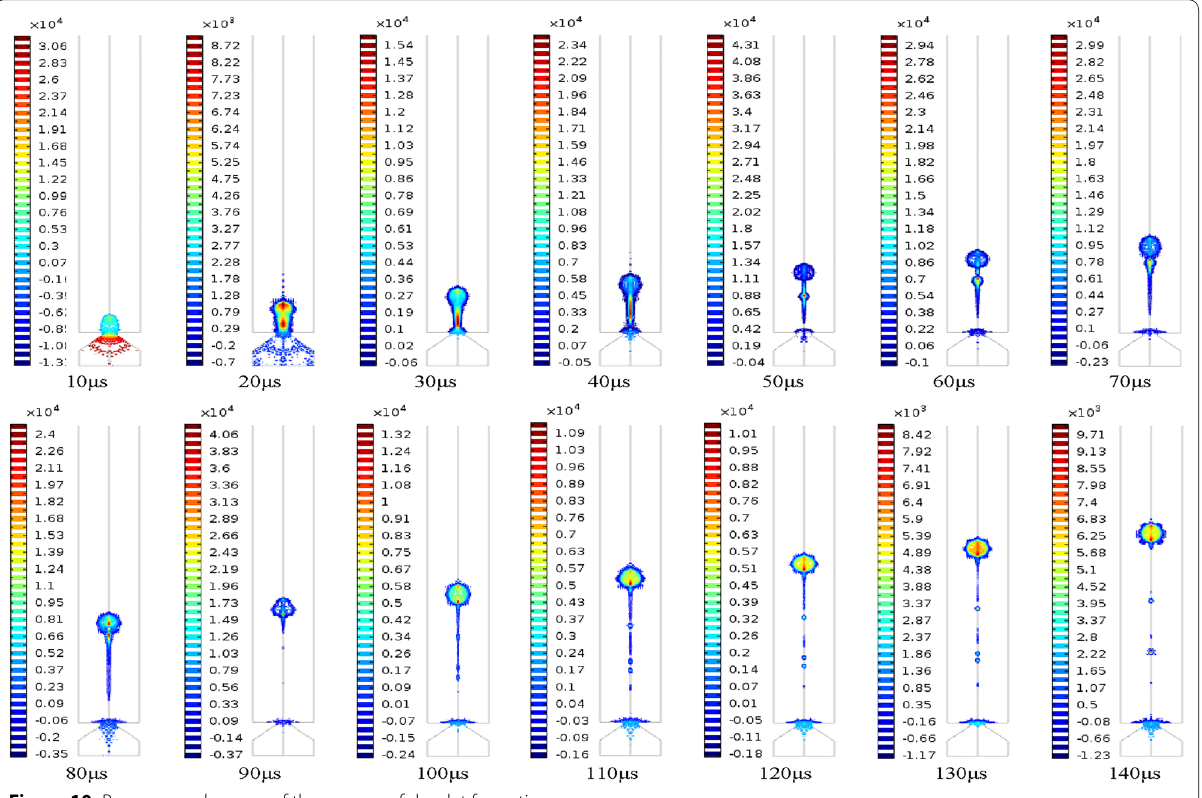
Figure 10 Pressure nephogram of the process of droplet